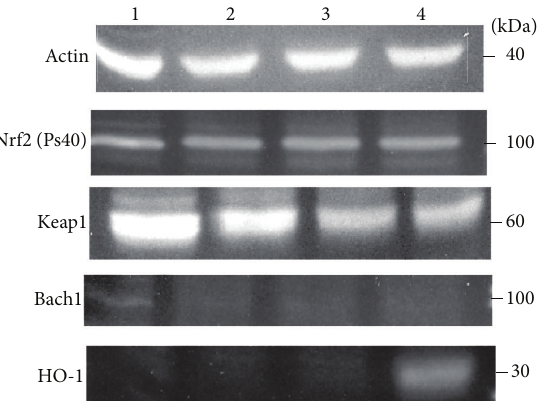
Figure7:EffectofZnPPonthelevelofphospho-Nrf2(pS40),Keap1, Bach1, and HO-1 in PC-3. PC-3 cells were treated with 10 𝜇 M ZnPP for 2h (lane 2), 4h (lane 3), and 24h (lane 4). Vehicle-treated cells were served as control (lane 1). Total proteins (50 𝜇 g) were analyzed by western blot as described in Section 2, using specific antibodies against 𝛽 -actin, phospho-Nrf2(pS40), Keap1, Bach1, and HO-1. Immunoreactive protein bands detected by WesternDot 625 appeared as fluorescent